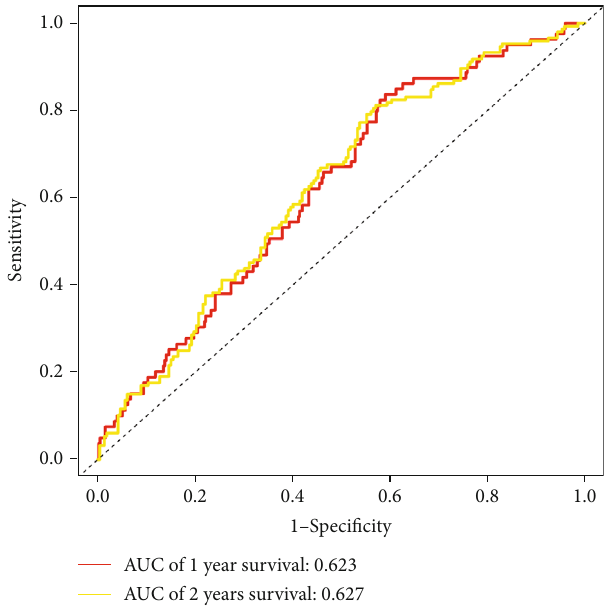
Figure 5: Time-dependent ROC curves for 1- and 2-year survival.